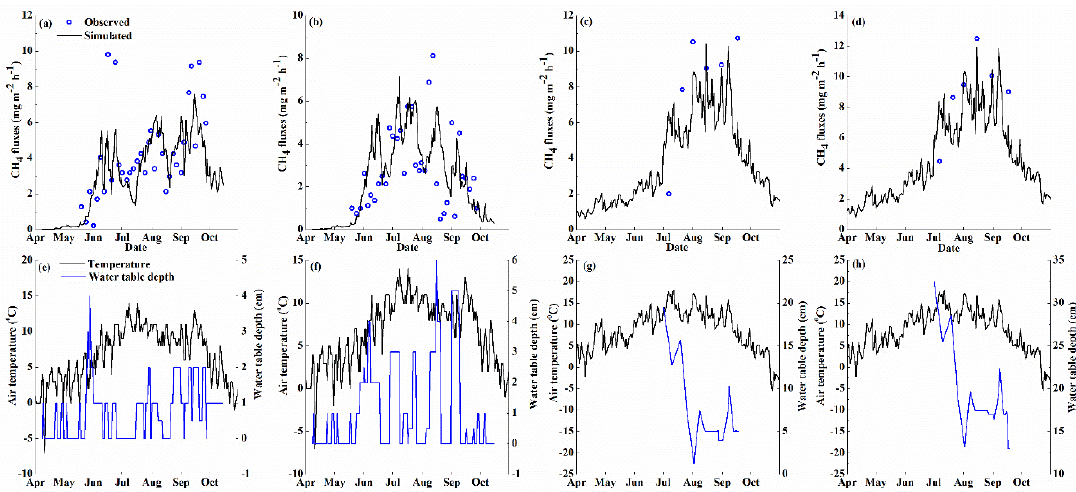
Figure 2. Simulated and observed seasonal variations of CH 4 emissions and the observed air temperatures and water table depths. ( a ), ( b ), ( c ) and ( d ) are the CH 4 emissions from the Zoige CME site, the Zoige CMU site, the Haibei CAL site and the Haibei HVU site; ( e ), ( f ), ( g ) and ( h ) are the air temperatures and water table depths from the Zoige CME site, the Zoige CMU site, the Haibei CAL site and the Haibei HVU site.